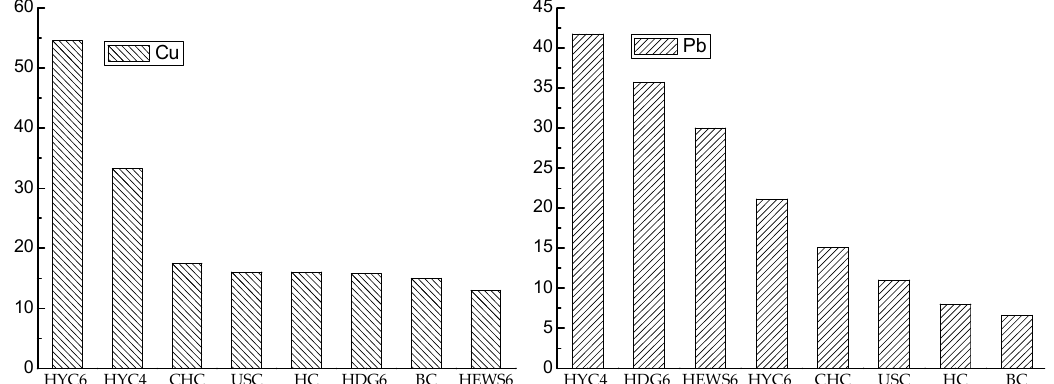
Figure 12. The content contrast for Cu and Pb form different mine of Jungar coalfield, and other coals. HYC4/6—Huangyuchuan No.4/6 coal, HDG6—Heidaigou No.6 coal, HEWS6—Haerwusu No.6